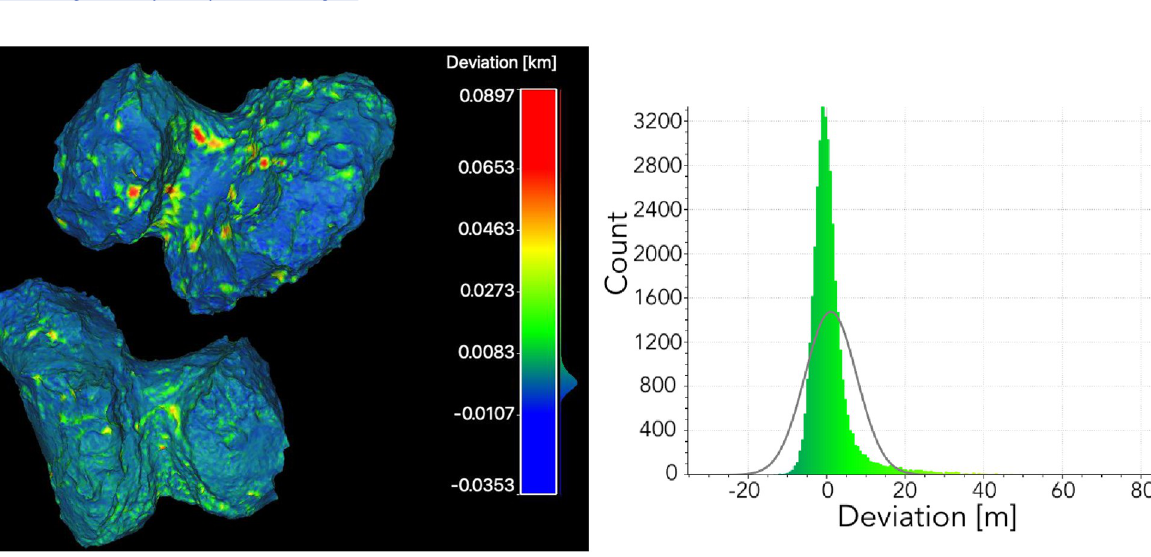
PLOS ONE | https://doi.org/10.1371/journal.pone.0263882 March 4, 2022 18 /